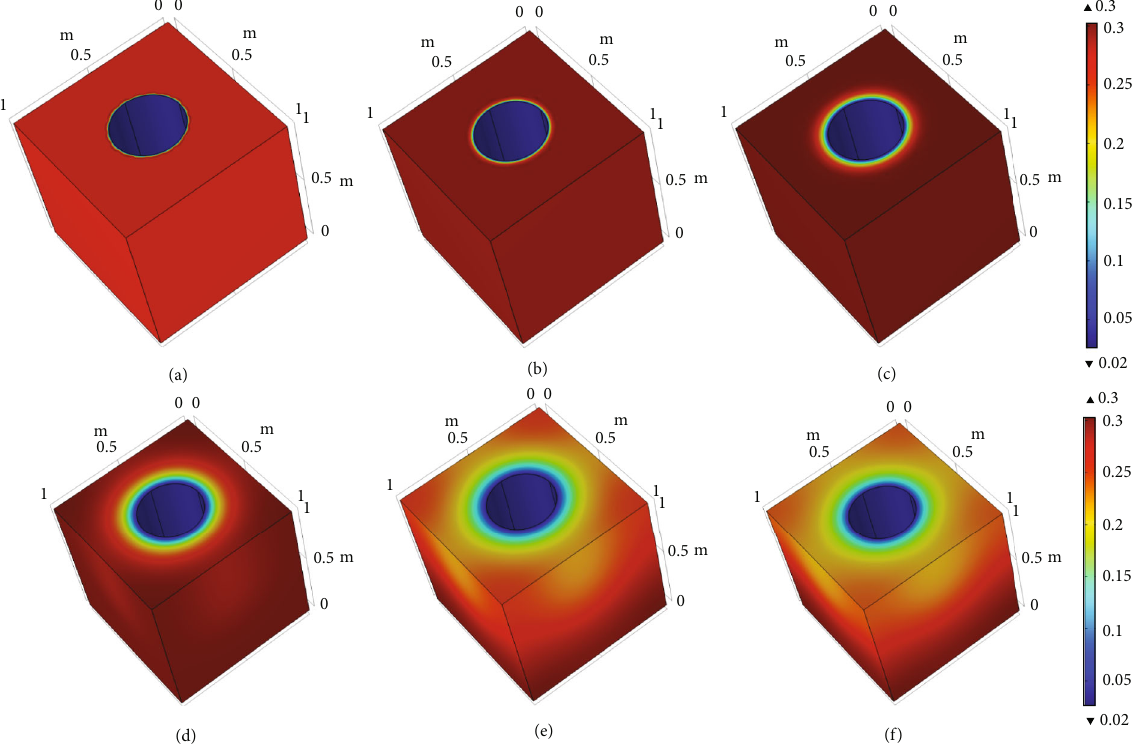
Figure 8: Pore pressure in the homogeneous coal rock: (a) t = 0 : 1 s, (b) t = 1 × 10 3 s, (c) t = 1 × 10 4 s, (d) t = 1 × 10 5 s, (e) t = 1 × 10 6 s, and (f) t = 1 × 10 7 s.